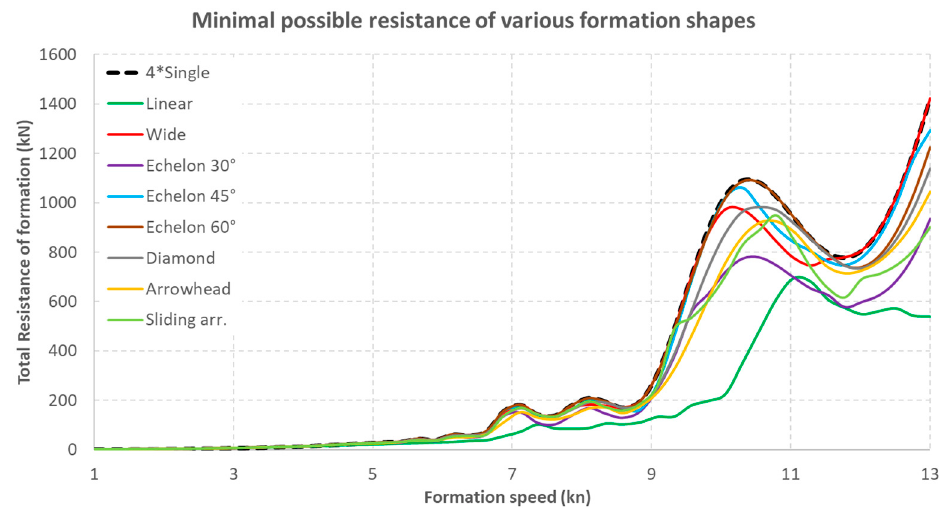
Figure 16. The distance providing the least resistance for a given formation speed in a linear formation.